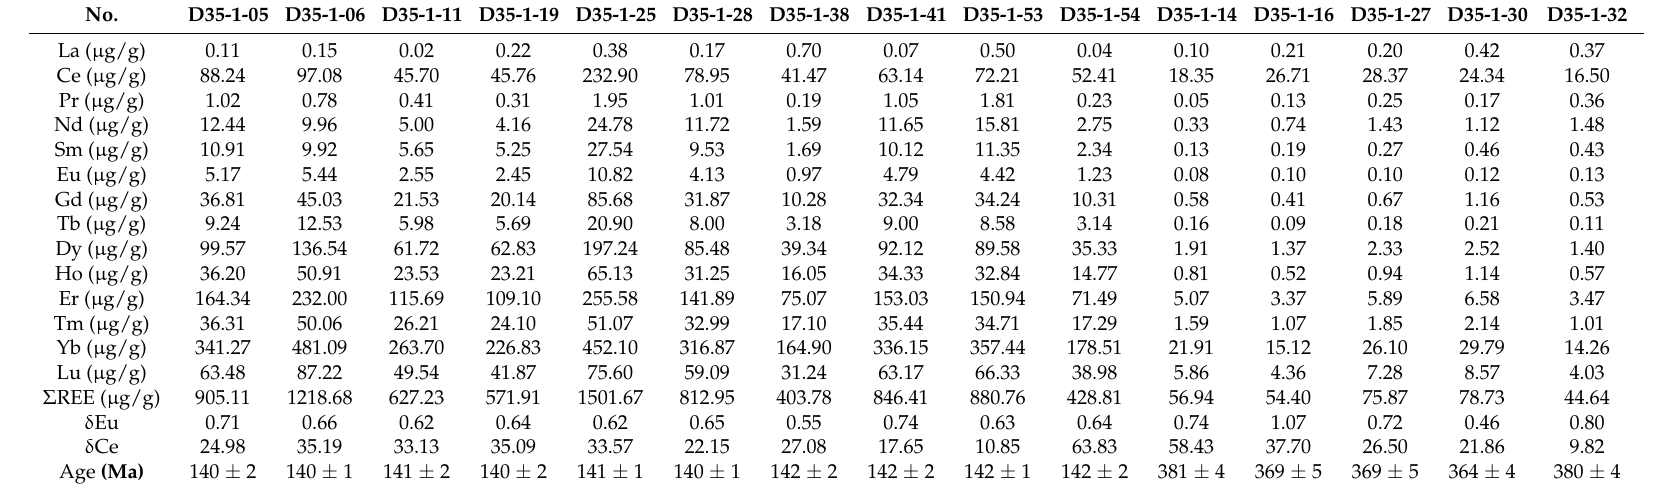
Table 3. REE composition of magmatic and hydrothermal zircons from the porphyritic granites in Dongping gold